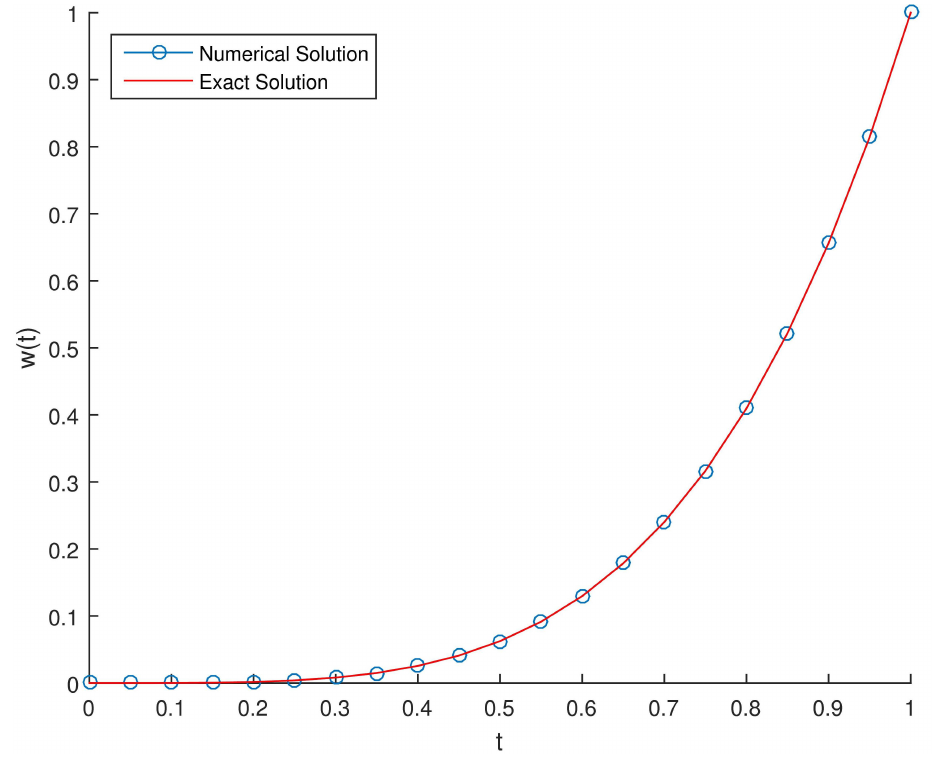
Figure 13. The demonstration of the approximate and exact solutions for Example 5.